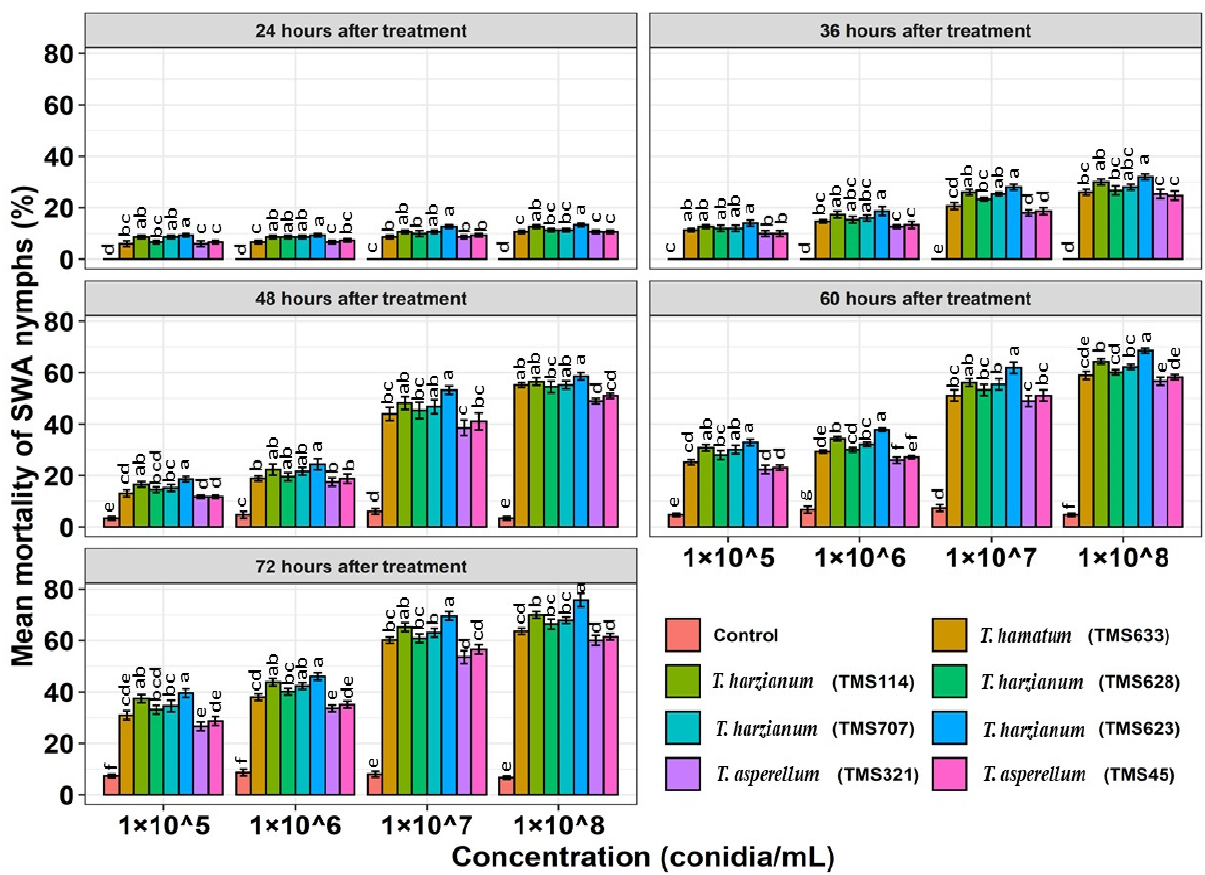
Figure 4. The efficacy of seven Trichoderma isolates against C. lanigera nymphs that were treated with four different concentrations (1 × 10 5 , 1 × 10 6 , 1 × 10 7 , and 1 × 10 8 conidia mL − 1 ) of conidia suspension up to 72 h treatment. Different letters indicate significant differences ( p ≤ 0.05) among the treatments. The columns represent the mean ± SEM ( n = 3). SEM = standard error mean.